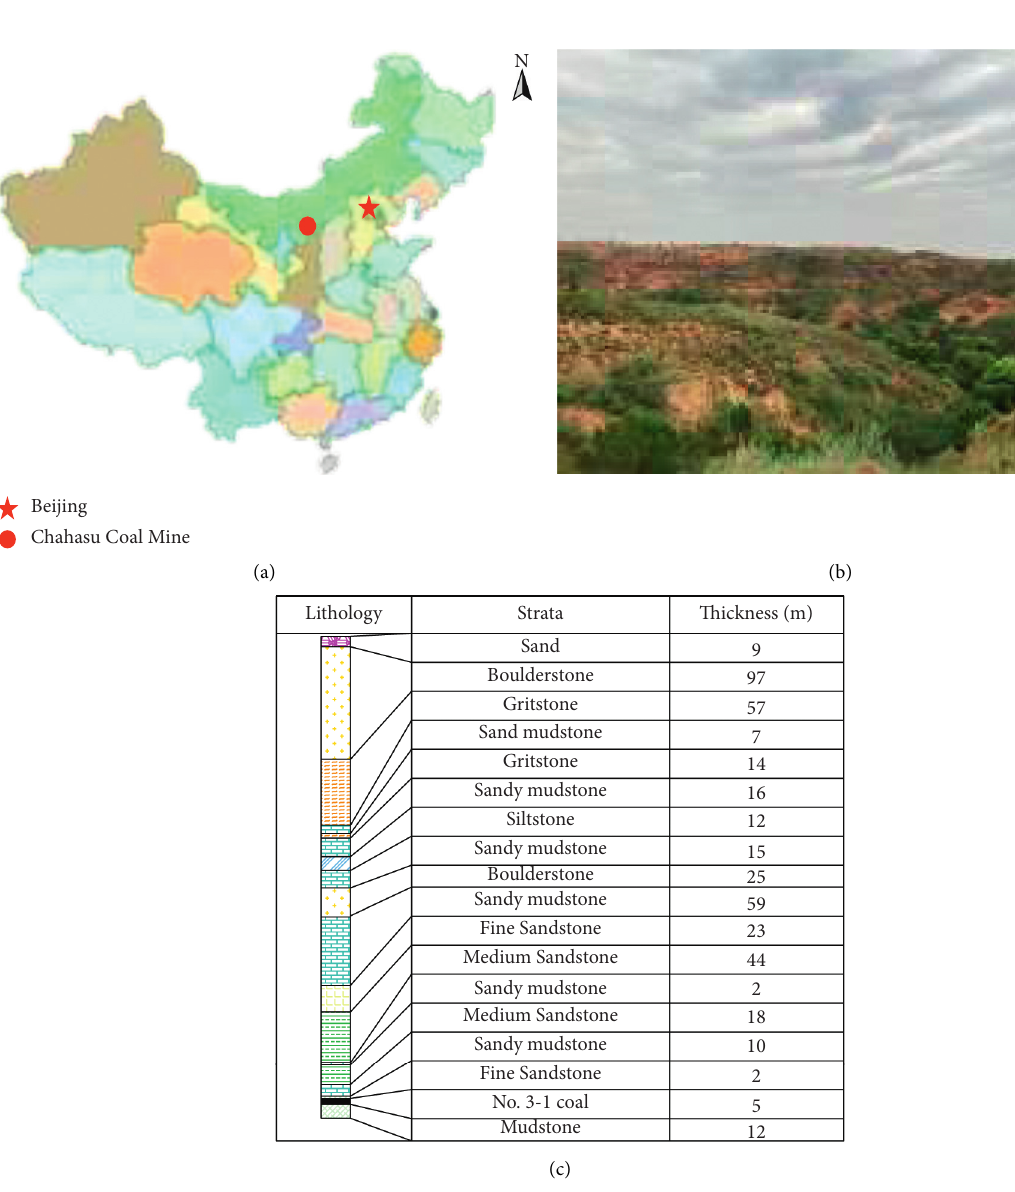
Figure 1: Chahasu Mine location and drill hole